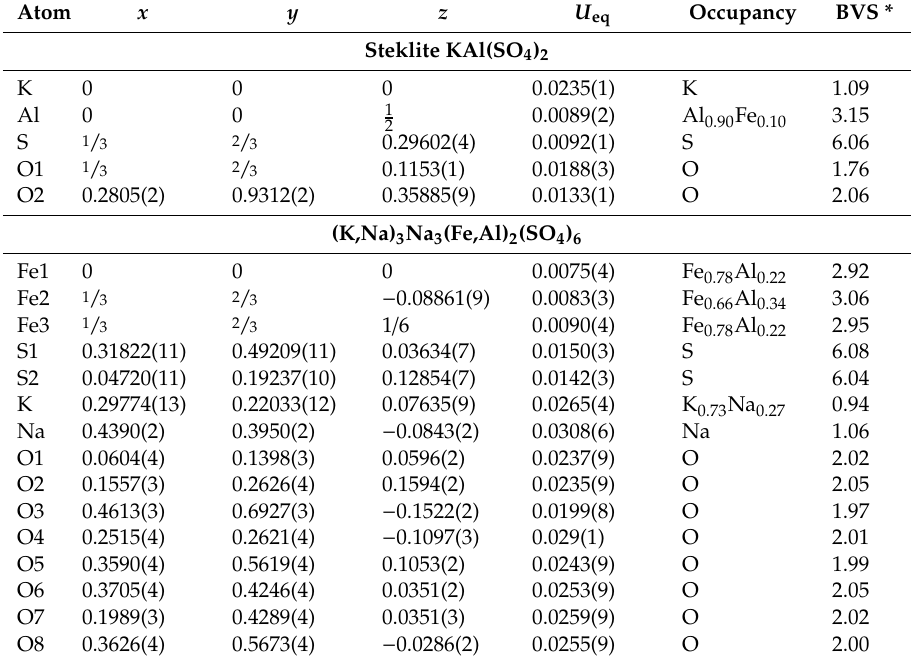
Table 2. Atomic fractional coordinates, site occupancies, bond valence sums, and equivalent displacement parameters (Å 2 ) for atoms of both studied